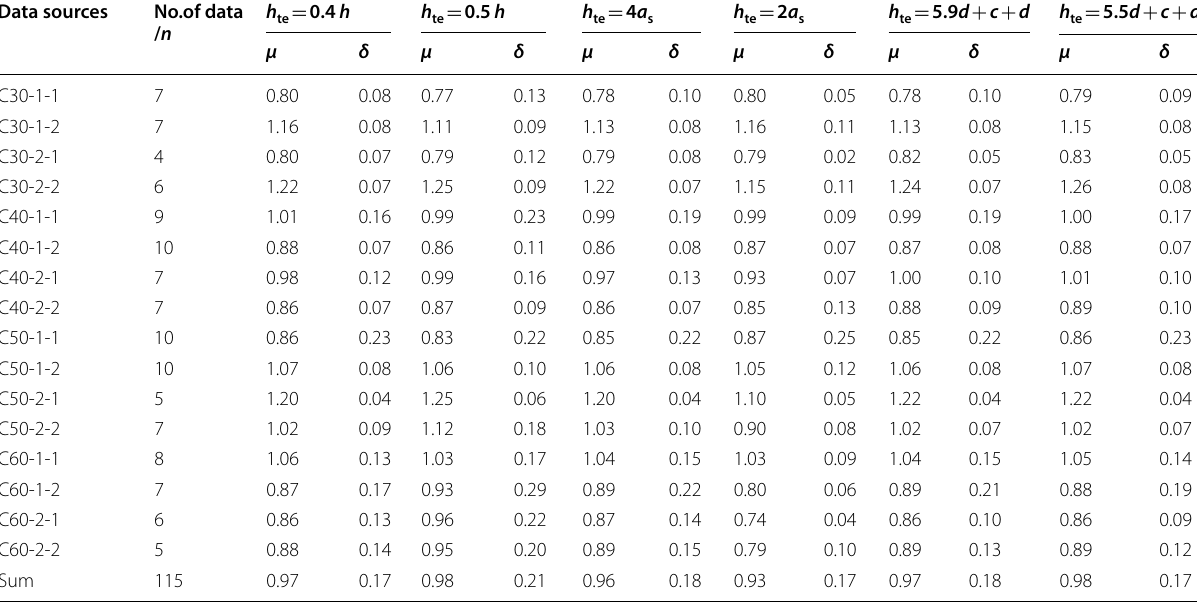
Table 12 Comparison results of w t max from RC beams with 600 MPa steel bars with w c1 max by the proposed methods. Data sources